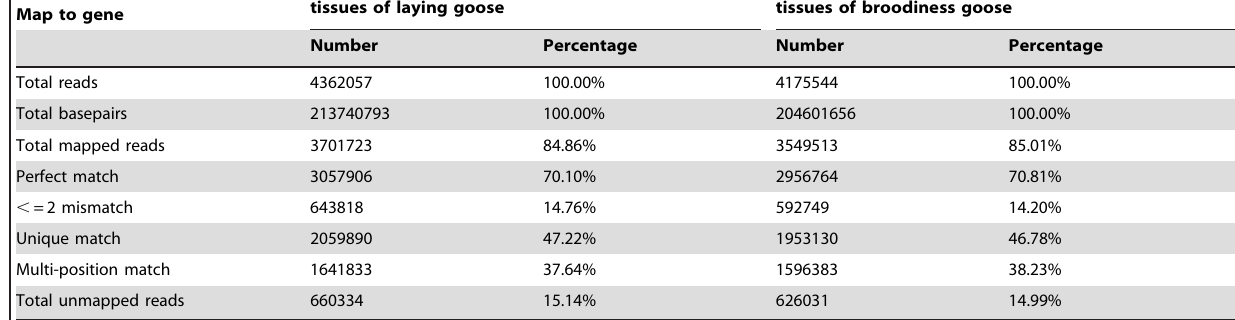
Table 3. Statistics of DGE sequencing.